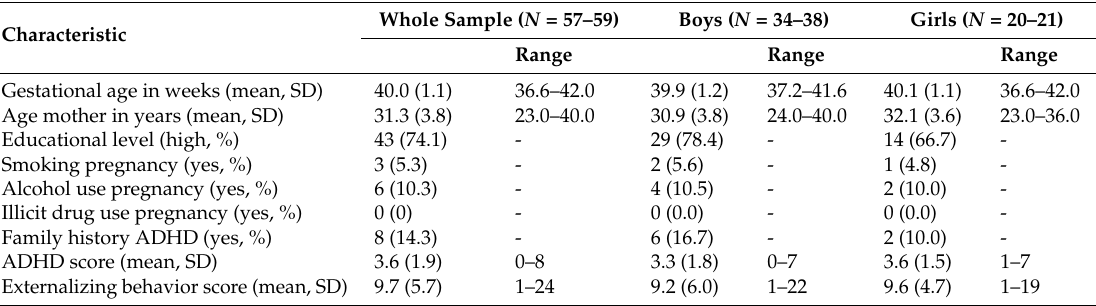
Table 2. Maternal and CBCL data for the study